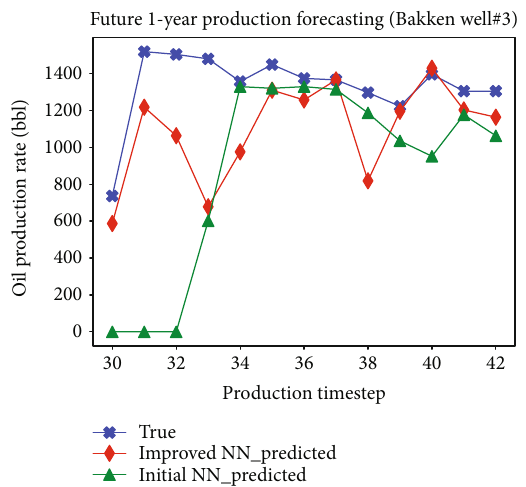
Figure 1: 1-year oil production where all features are considered in Bakken formation.